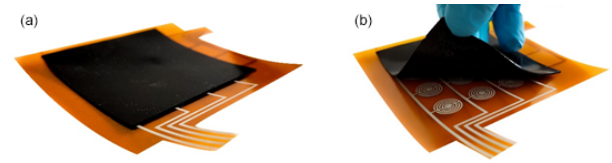
Figure 2. (a) Sensor matrix based on a CNT polymer composite on Kapton substrate. (b) Self-adhesive property of the polymer com- posite on the electrode